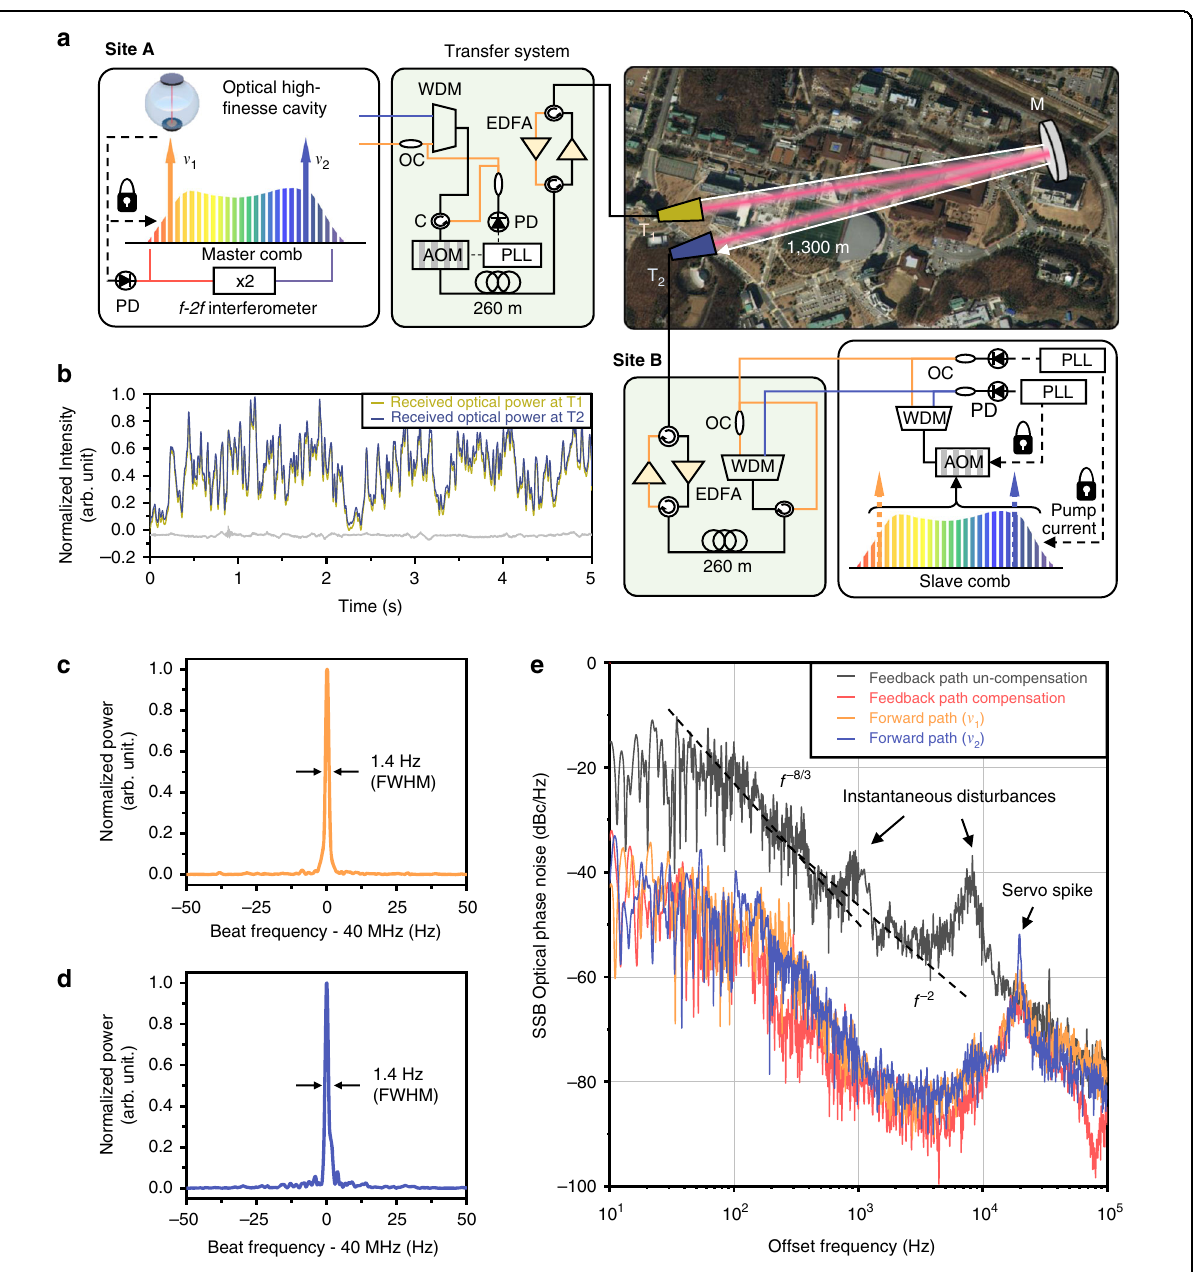
Fig. 1 Frequency comb-to-comb stabilization over a 1.3 km free-space optical link. a Overall system con fi guration. The master comb is located at Site A in stabilization to a high- fi nesse optical cavity. A slave comb to be stabilized is placed at Site B. Two optical frequencies ν 1 (1531 nm) and ν 2 (1564nm) are extracted from the master comb at Site A, transferred to Site B through a free-space optical link. b Time-dependent power fl uctuation of the optical carrier signals received by the transceivers; T 1 at Site A and T 2 at Site B. Grey line at bottom denotes the calculated power difference between T 1 and T 2 . c , d Linewidths of the transferred optical frequencies ν 1 and ν 2 , respectively, at Site B with phase noise suppression control. e Single sideband (SSB) phase noise spectra of forward path (one-way) and feedback (two-way) optical carrier signals. WDM Wavelength division multiplexer, AOM Acousto-optic modulator, C Circulator, EDFA Erbium-doped fi ber ampli fi er, OC Optical coupler, PD Photodetector, T Transceiver, M Flat mirror, and PLL Phase-locked